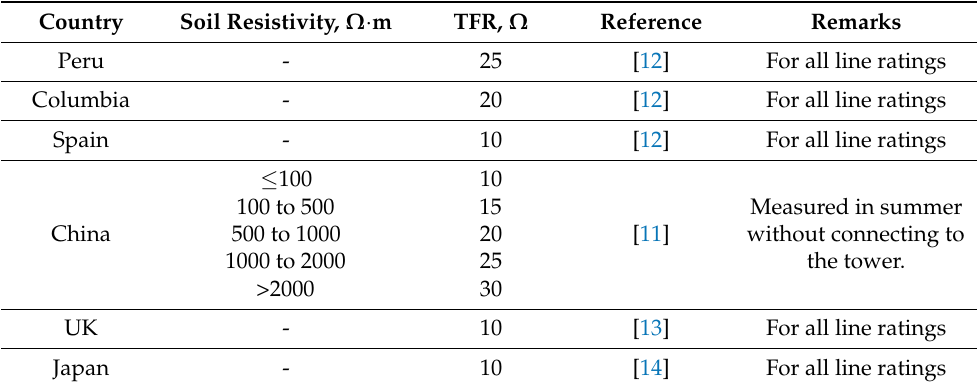
Table 1. Earthing resistance established by other